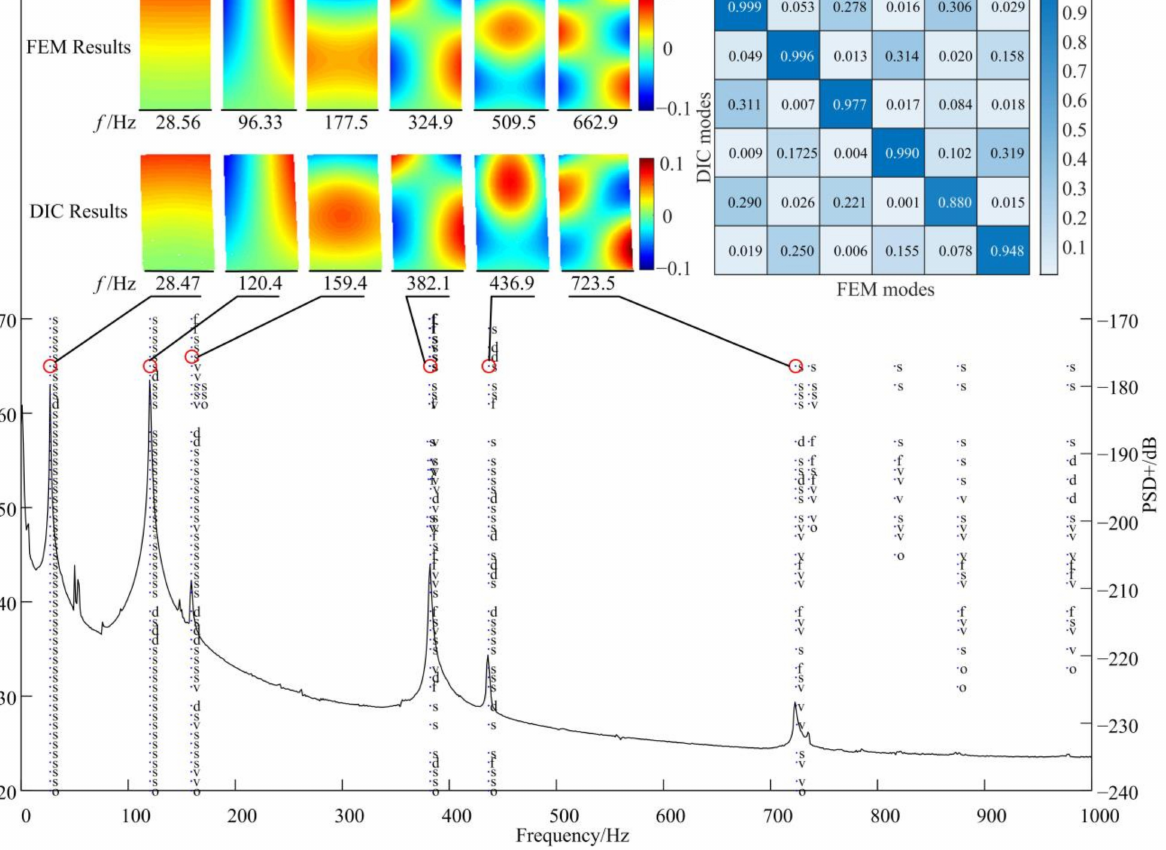
Figure 10. Stable chart and displacement mode shapes in out-of-plane direction.